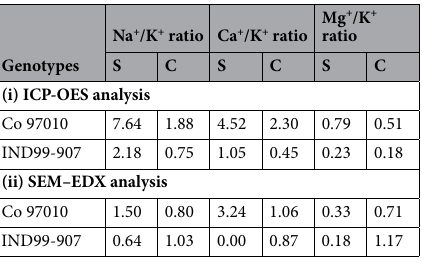
Table 1. Estimated Sodium–Potassium ratio by ICP-OES and SEM–EDX method at 175 mM for 15 days in pot culture